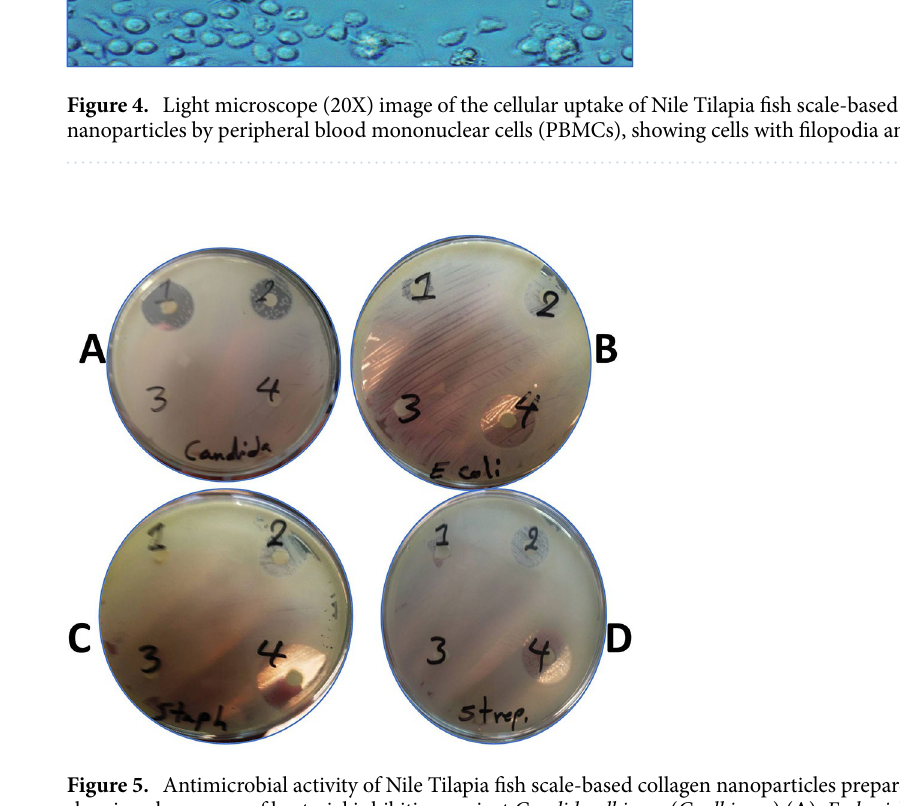
Figure 5. Antimicrobial activity of Nile Tilapia fish scale-based collagen nanoparticles prepared by ethanol showing clear zones of bacterial inhibition against Candida albicans ( C. albicans ) ( A ), Escherichia coli ( E. coli ) ( B ), Staphylococcus aureus ( S. aureus ) ( C ) Streptococcus mutans ( S. mutans ) ( D ) using 5 μg (1) and 10 μg (2). Antimicrobial activity of Nile Tilapia fish scale-based collagen nanoparticles prepared by acetone showing clear zones of bacterial inhibition against S. aureus , S. mutans , E. coli, and C. albicans using 5 μg (3) and 10 μg